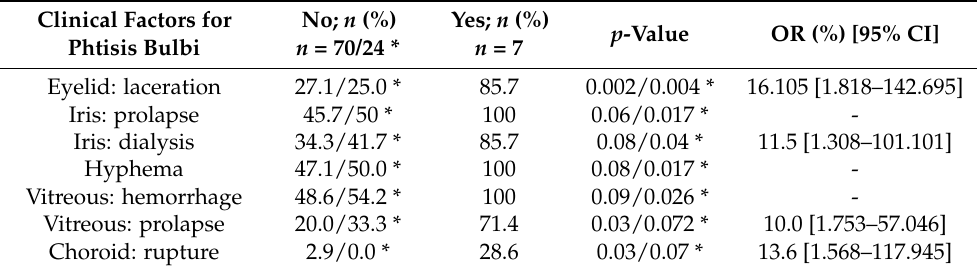
Table 8. Relationship between clinical factors and phthisis